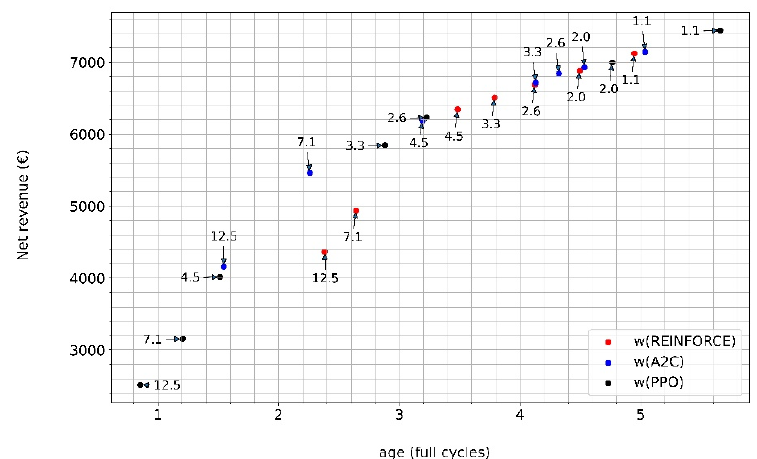
Figure 10. Scatter plot of net revenue and aging.